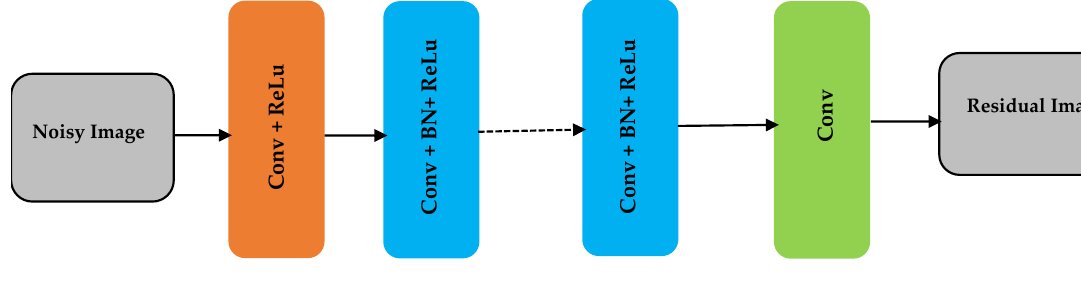
Figure 2. Architecture of DNCNN.